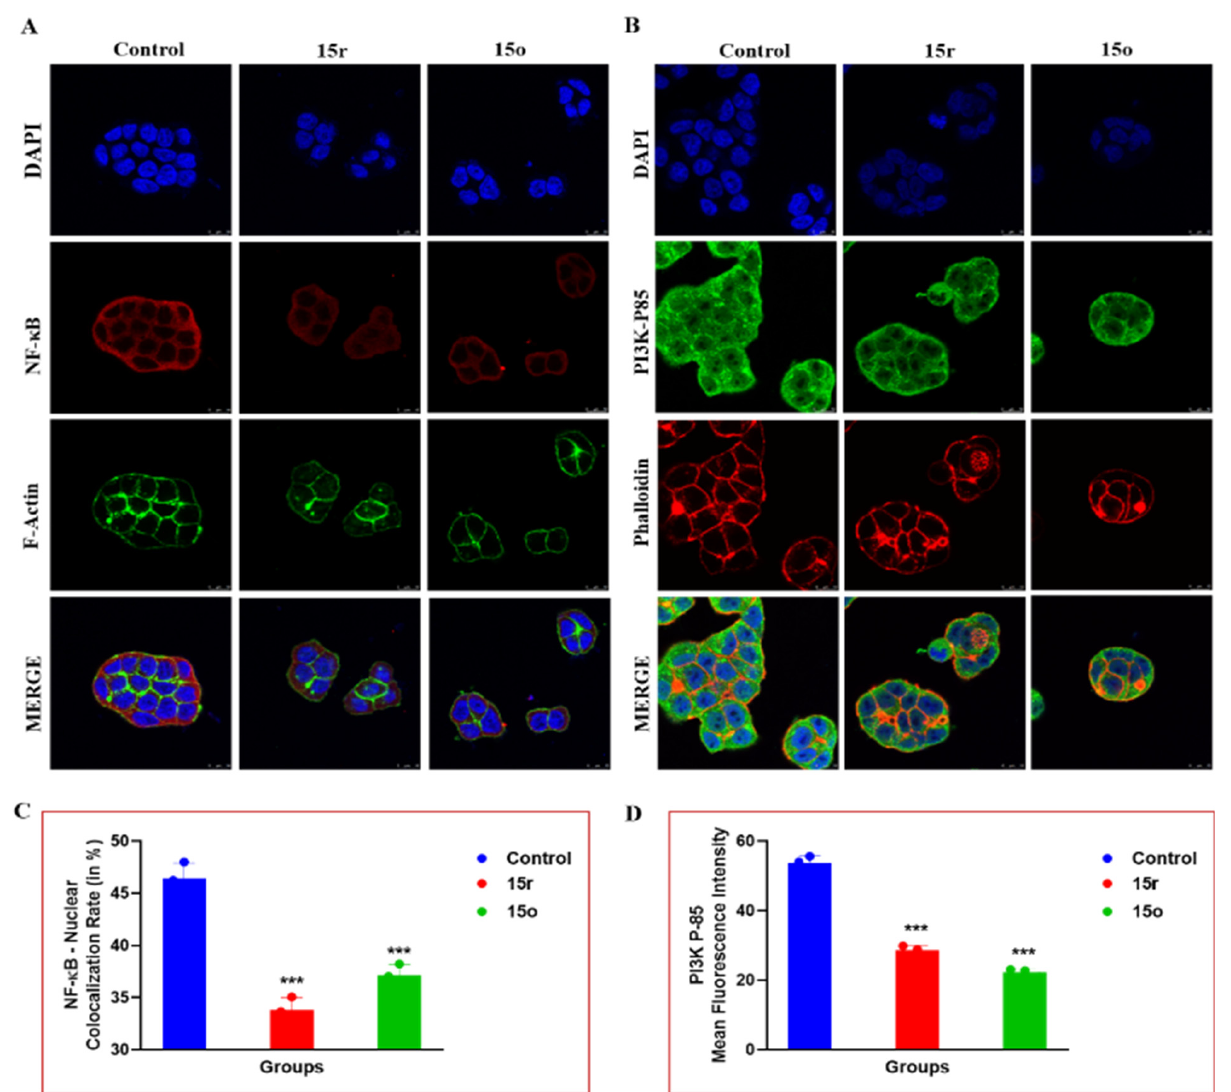
Figure 8. Represented images depicting immunofluorescence analysis of ( A ) NF- κ B along with F-Actin in HT-29 cells. Similarly, HT-29 cells were stained with ( B ) PI3K-p85 and Phalloidin Red. Treatment with different 1,2,4-triazolo-linked bis -indolyl conjugates ( 15a–r ) significantly reduced the expressions of NF- κ B in the nucleus and PI3K p85 levels in HT-29 colon cancer cells. Images were acquired using a confocal microscope at 63 × and 2 × magnification. ( C , D ) Statistical significance was determined by one-way ANOVA followed by Tukey’s post-hoc analysis, where *** p < 0.001 represents control vs. 1,2,4-triazolo-linked bis -indolyl conjugates ( 15o and 15r ) in the treatment